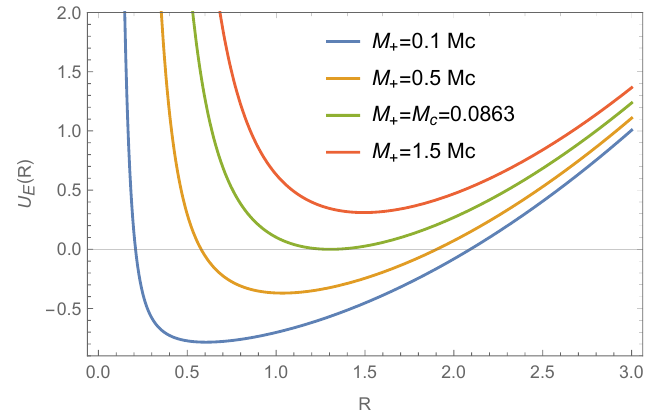
. The critical black hole 16 πG